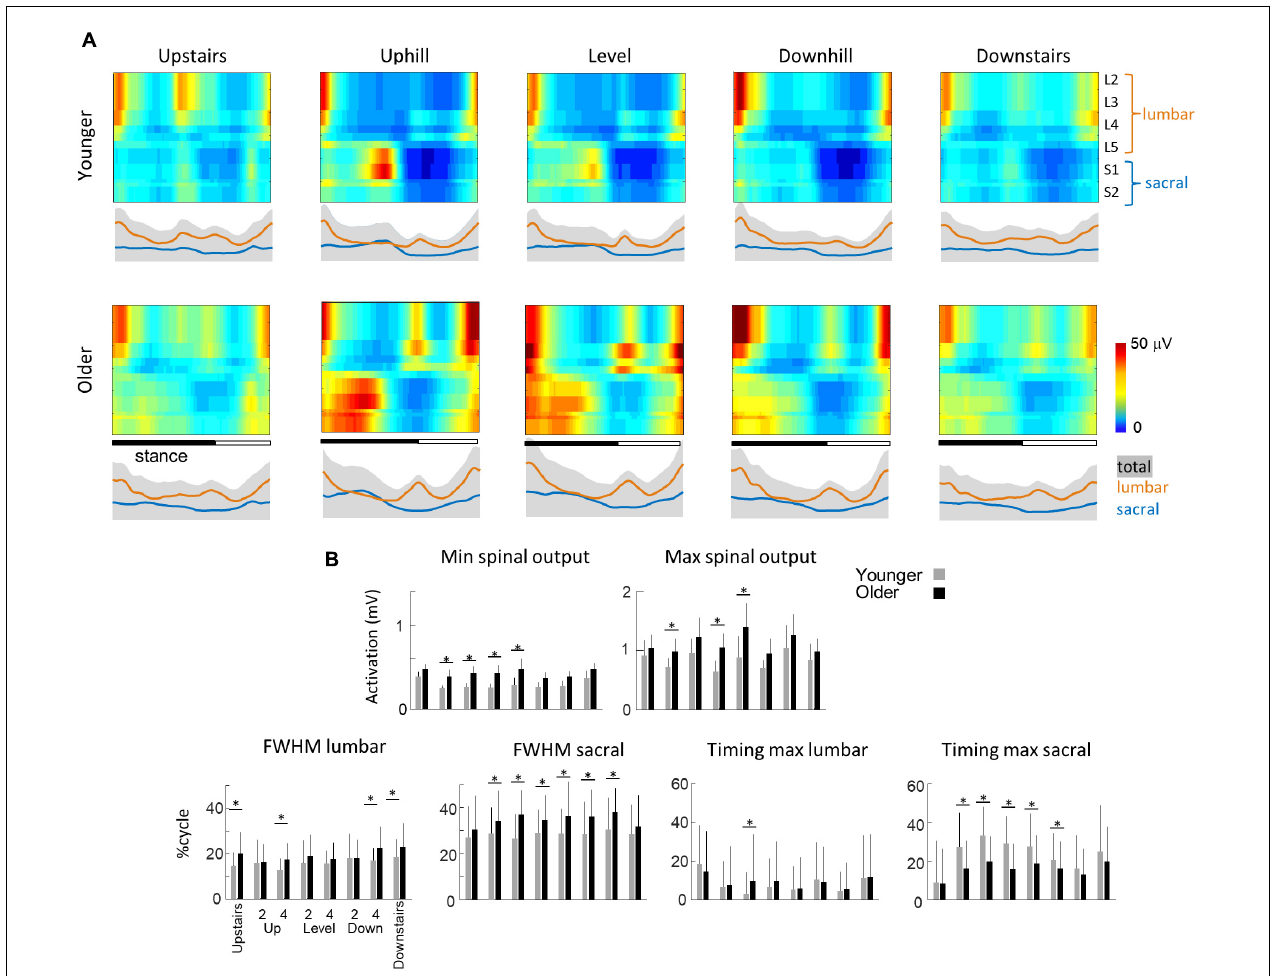
FIGURE 6 | Unilateral spatiotemporal spinal motor outputs computed from ensemble-averaged EMGs across all subjects in all conditions ( Table 1 ). (A) Motor output (reported in µ V) is plotted as a function of gait cycle in young (top) and older (bottom) adults. The thin green and red lines correspond to the activation of the lumbar and sacral segments, respectively. The gray area is the sum of all segments and reflects the level of activation (B) average minimal and maximal level of activation of the spinal motor output, average FWHM, and timing of the maximal activation of the lumbar and sacral segments. Bars are presented for each condition and at each speed (2 and 4 indicate the speed in km h − 1 ). Other indications as in Figure 2